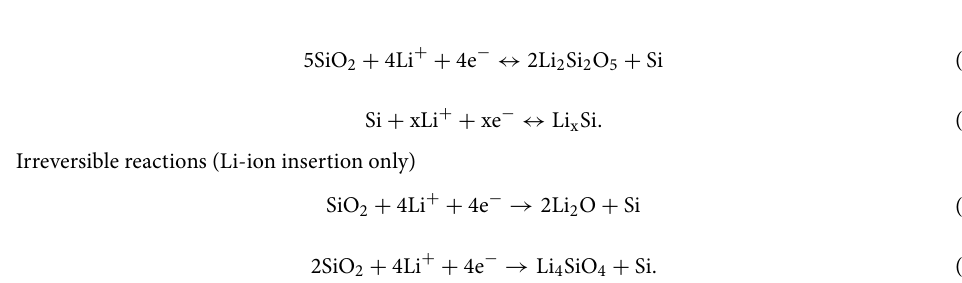
Irreversible reactions (Li-ion insertion only)